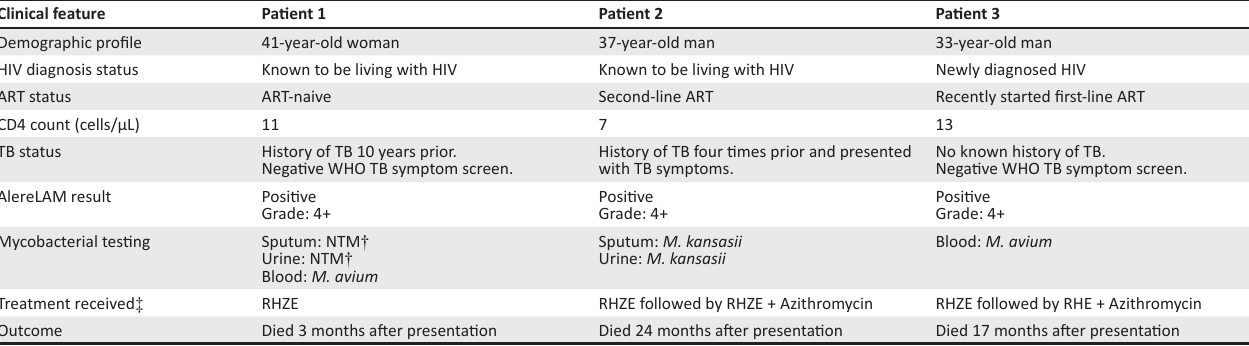
TABLE 1: Clinical characteristics of three patients. Clinical